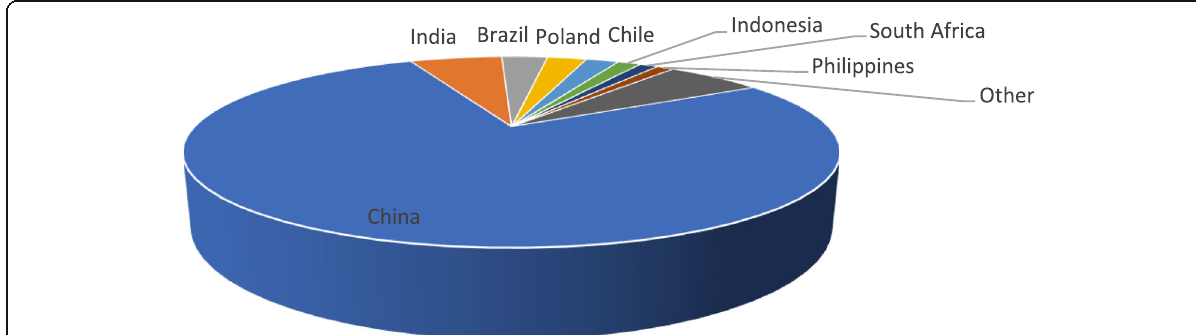
Fig. 2 Cumulative LMIC ’ s Green Bond Issuance from 2012 to 2019 (%) . Source: International Financial Corporation, Global Macro & Market Research, Bloomberg, Environmental Finance, Climate Bonds Initiative (2019)